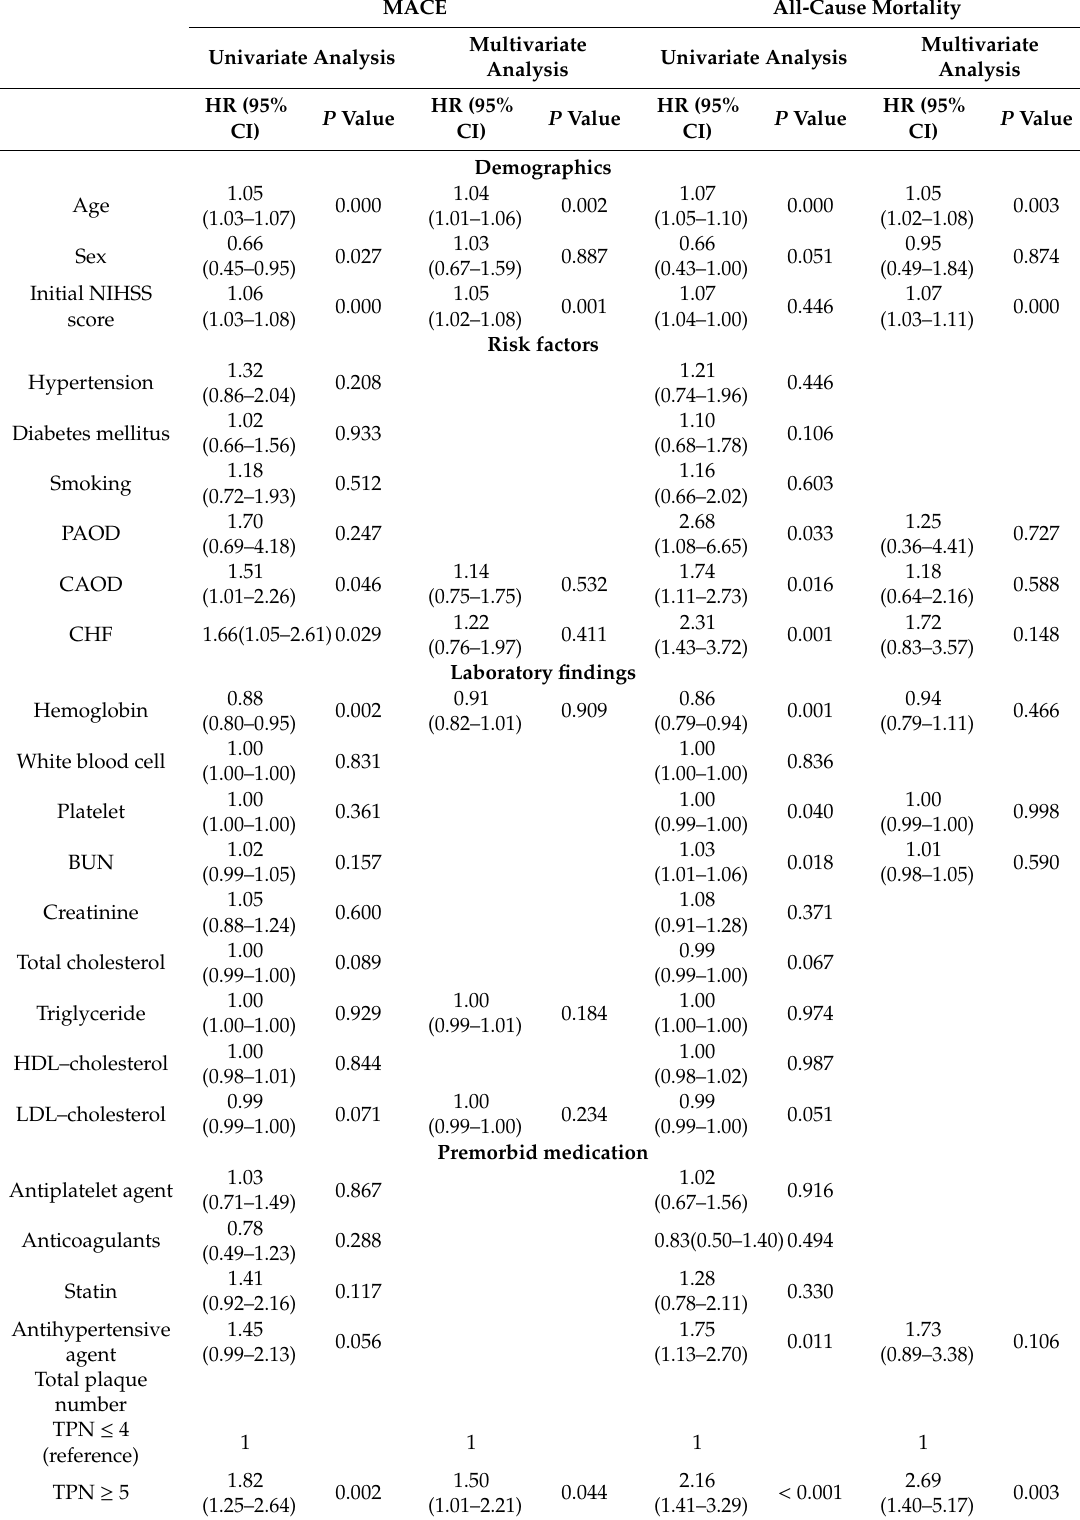
Table 2. Unadjusted and adjusted hazard ratio for MACE and all-cause mortality according to the total carotid number of